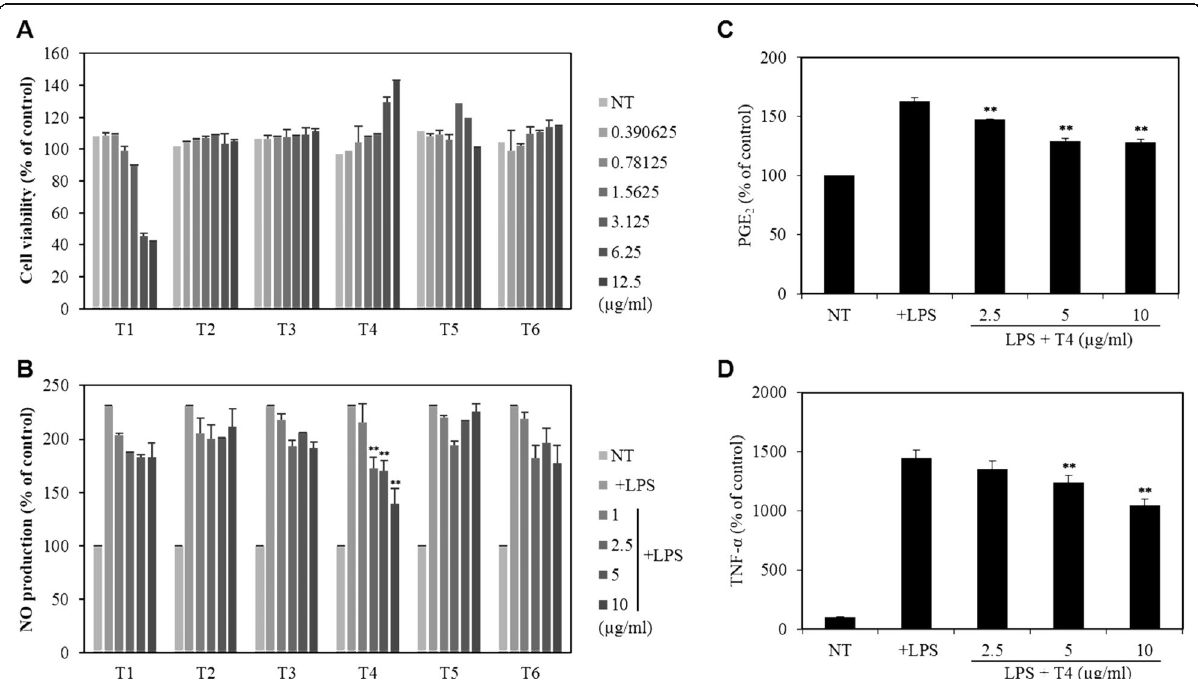
Fig. 4 Effect of plant extract on viability of RAW264.7 macrophage cells ( a , b ) and anti-inflammatory effect of T4 in LPS-stimulated RAW264.7 macrophage cells ( c, d ). Statistical analysis was carried out using one-way ANOVA followed by t-test. *Statistically significant between cell lines treatment with extract at ** p < 0.001 vs. LPS-treated